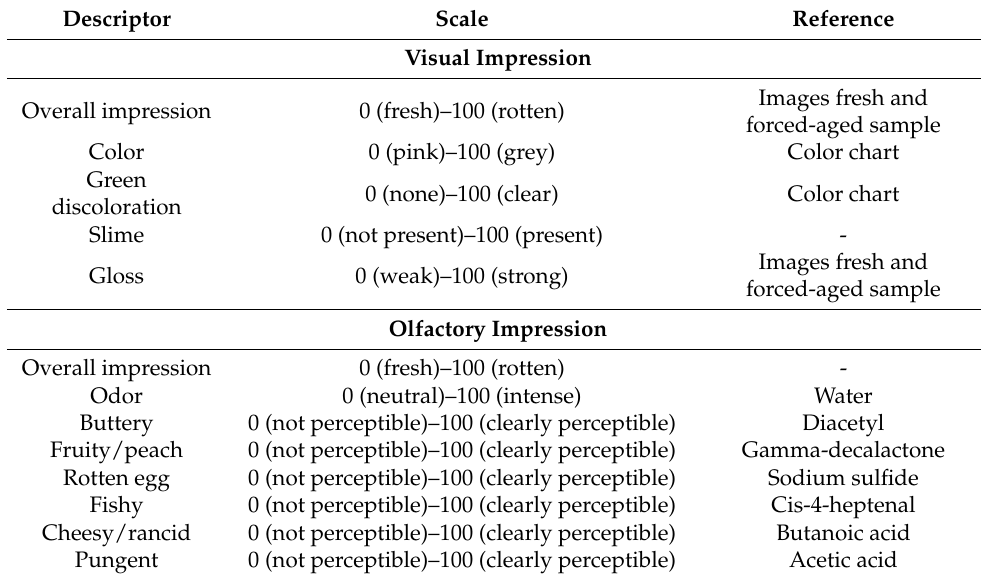
Table 2. Chosen descriptors for the sensory evaluation, based on the descriptive analysis of the panel training. The references and scale for the olfactory impression were also used for the second part of the training—the odor identification test.